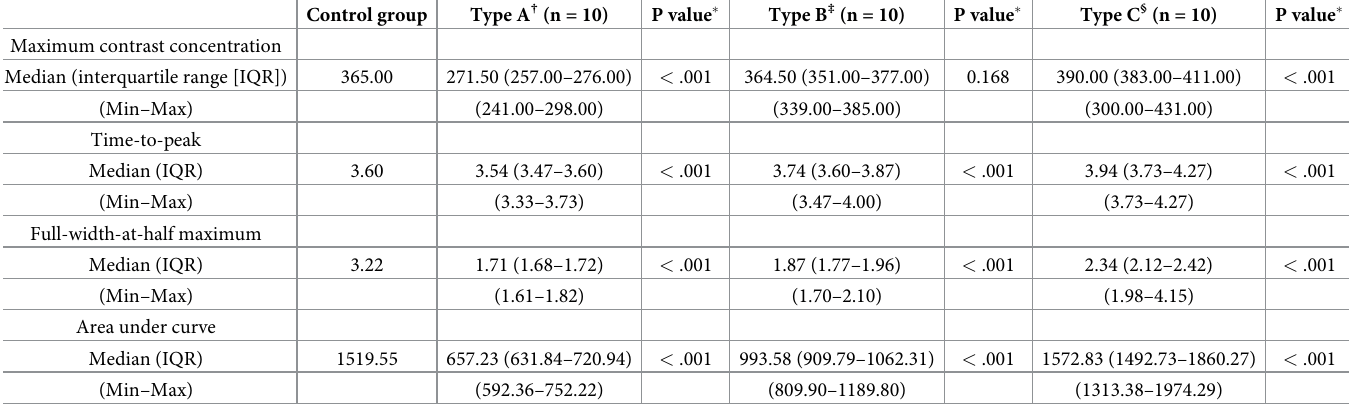
Table 1. Four parameters for temporal changes in contrast opacity in the phantom types A, B, and